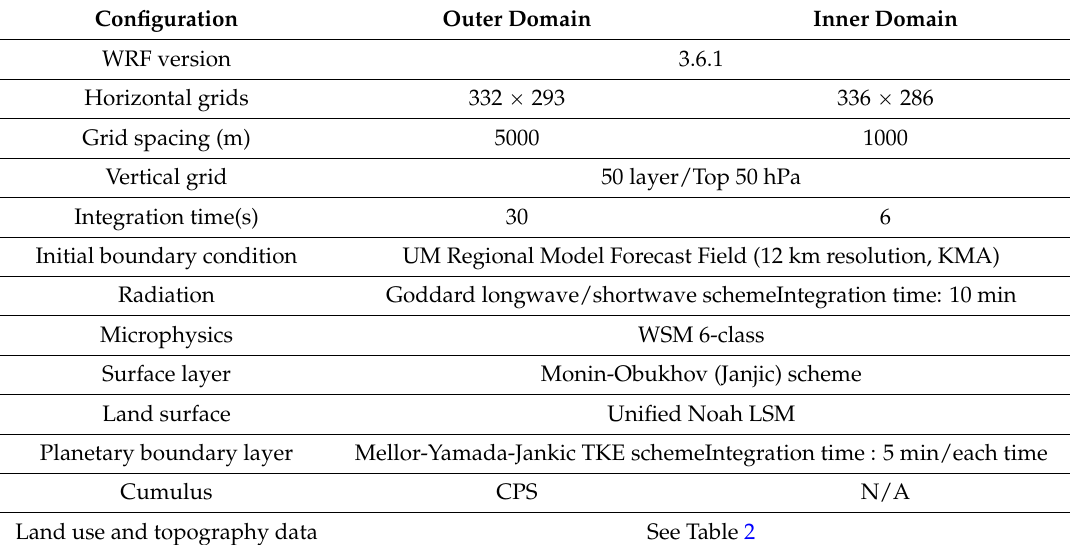
Table 1. Summary of model configuration and physical